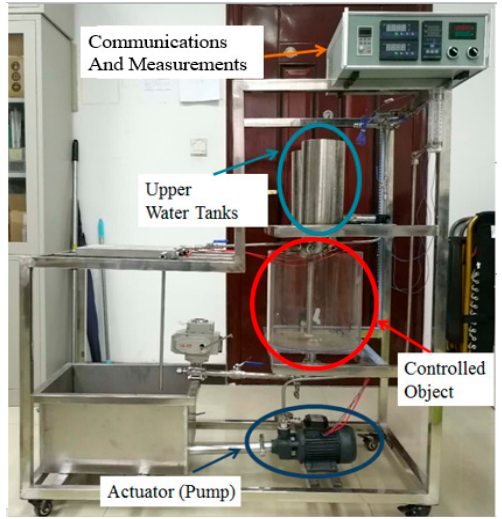
Figure 12. Photo of water pump experimental platform.